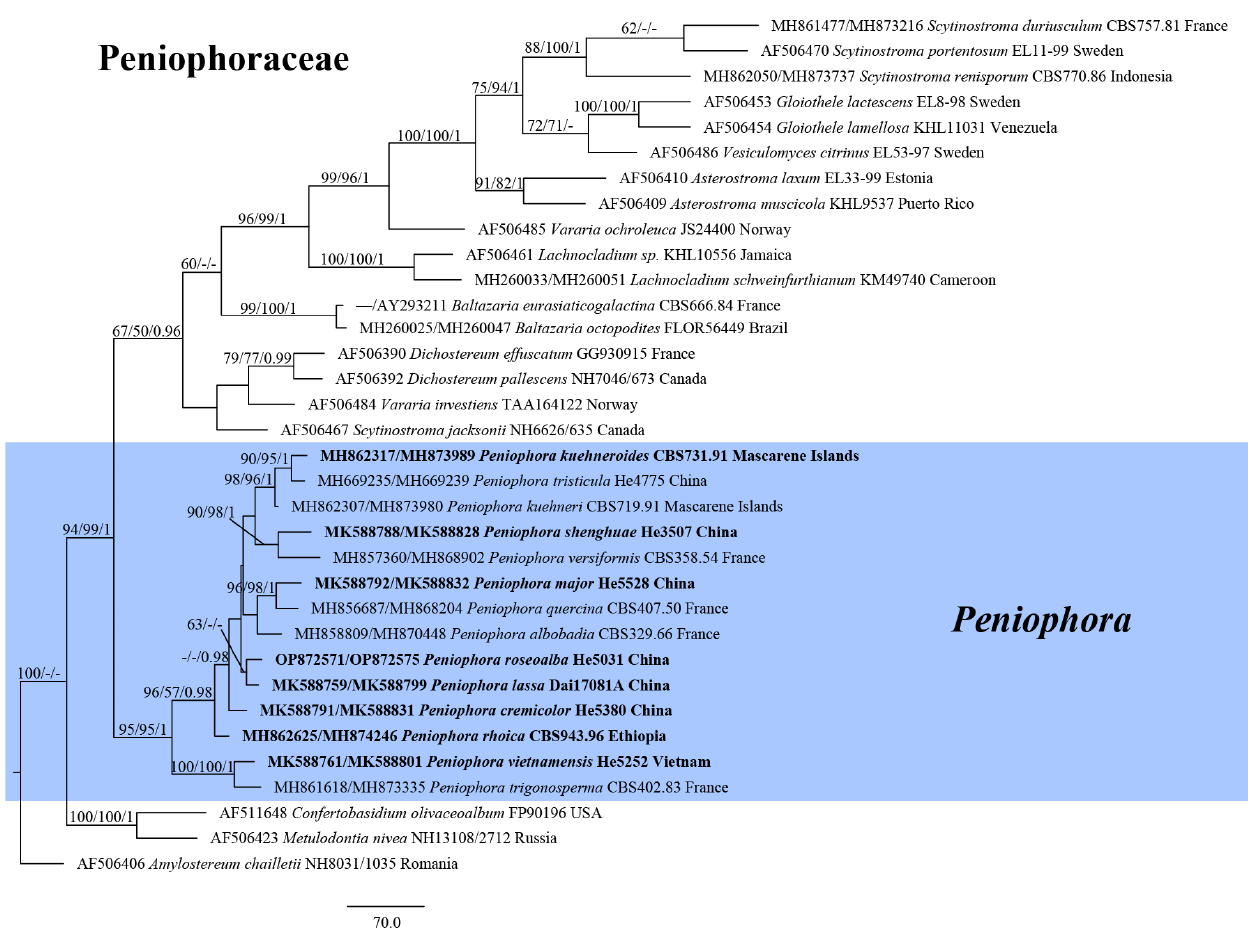
Figure 1. Phylogenetic tree obtained from maximum parsimony analysis of ITS-28S sequence data of Peniophoraceae. Branches are labeled with parsimony bootstrap values ( ≥ 50%, front), likelihood bootstrap values ( ≥ 50%, middle) and Bayesian posterior probabilities ( ≥ 0.95, back). New species and new combinations are set in bold.